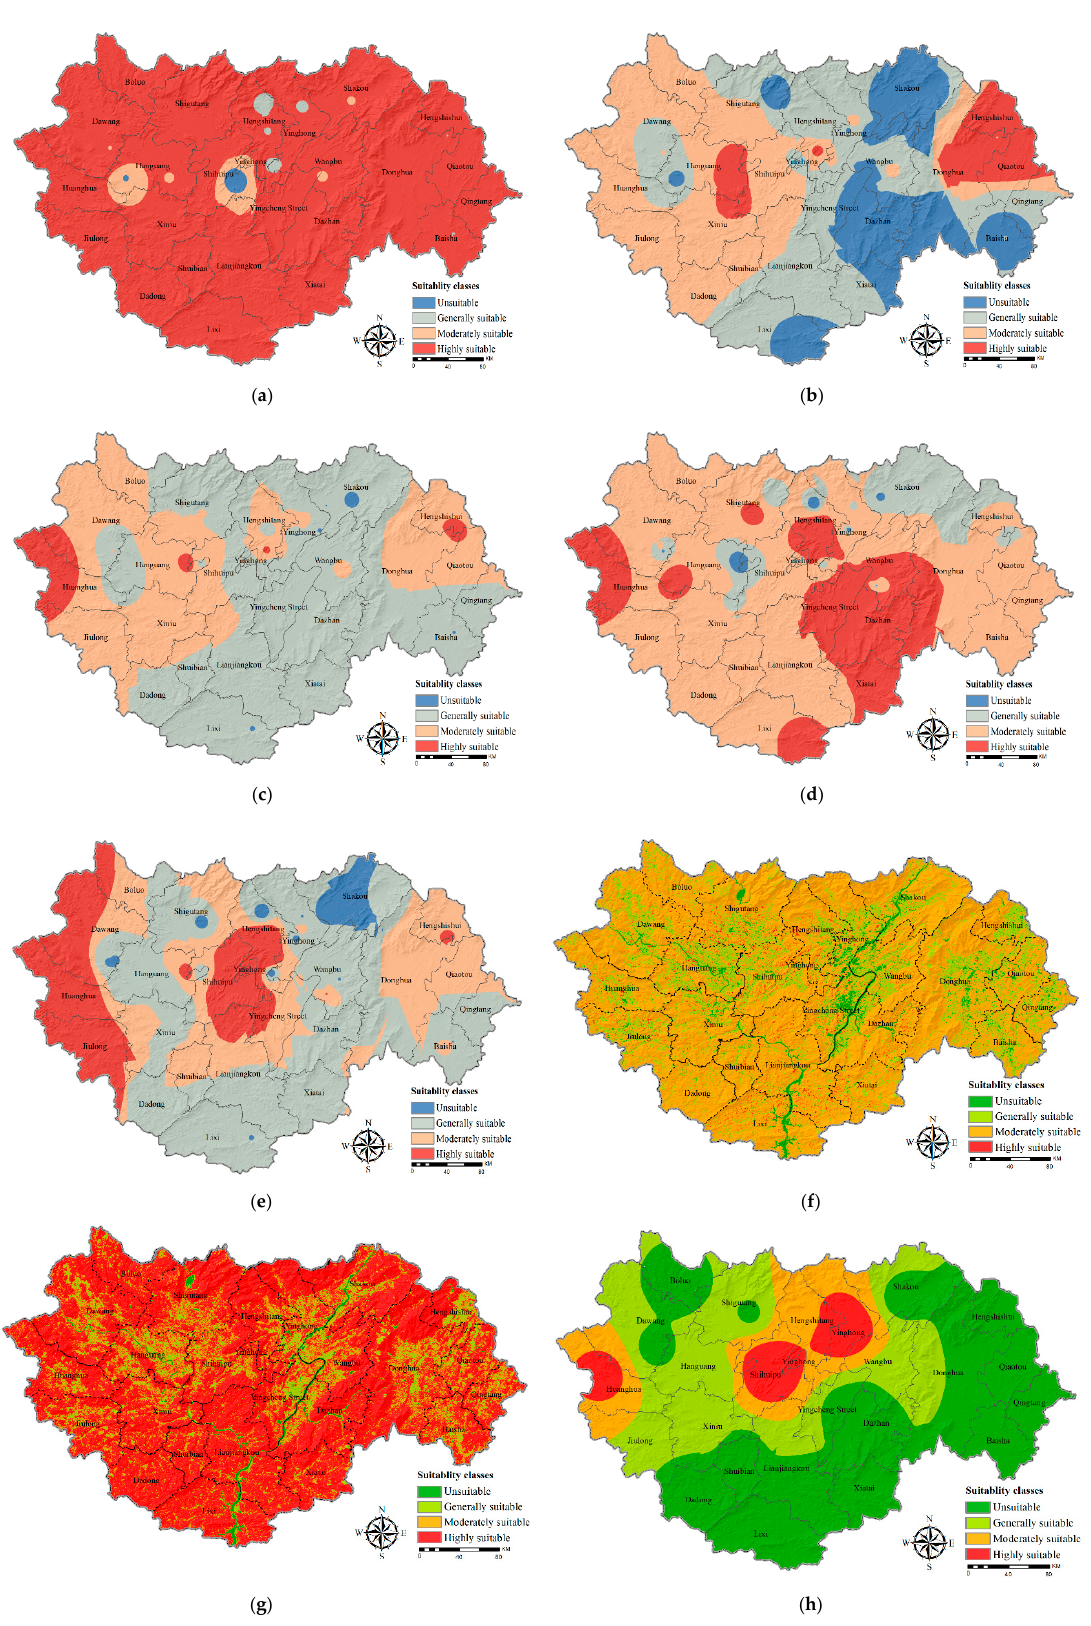
Figure 5. Suitability classes for individual factors of soil and human factors (( a ) is pH, ( b ) is soil organic matter, ( c ) is nitrogen, ( d ) is potassium, ( e ) is phosphorus, ( f ) is LULC, ( g ) is NDVI, ( h ) is tea production).